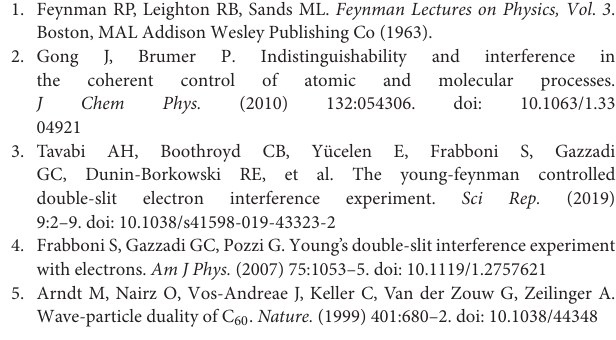
FIGURE 5 | Control of molecular scattering by laser polarizations. Here, the pump laser polarization is kept fixed parallel to the X axis, corresponding to β the Stokes laser polarization is rotated from α as the XZ plane. The top panel shows the calculated scattering images of rotationally relaxed HD ( v scattering can be directed at different